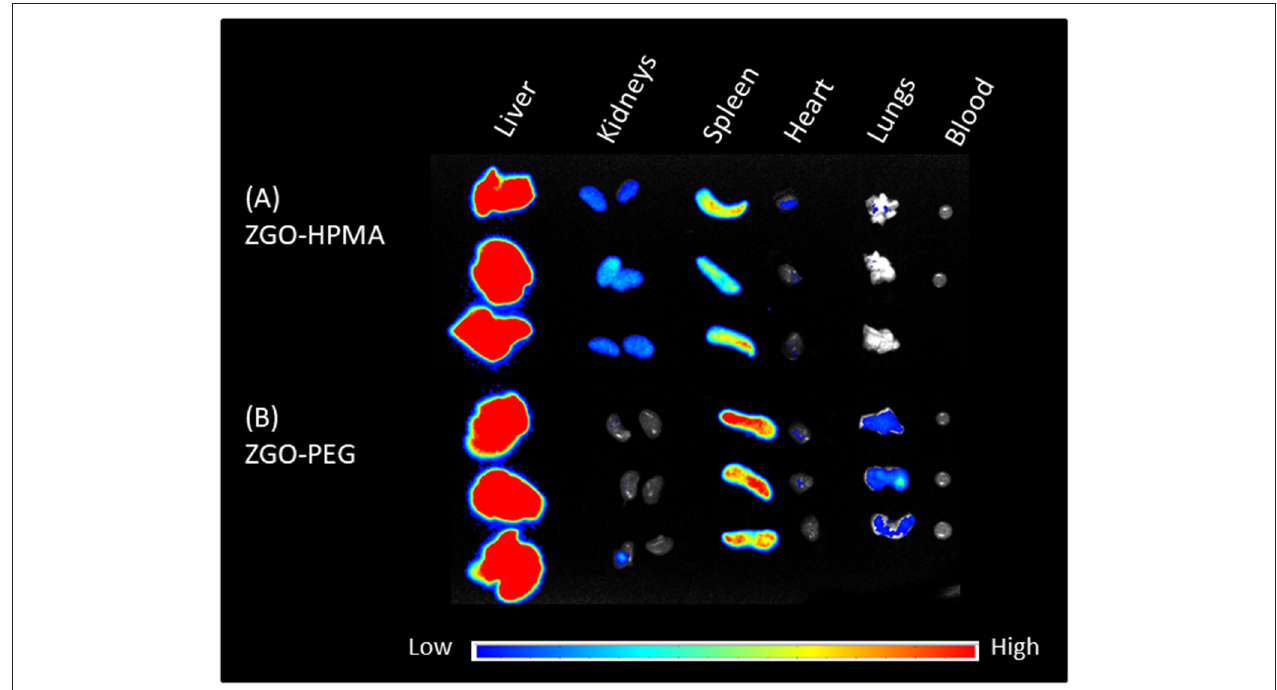
FIGURE 6 | Ex vivo imaging of main organs and blood 24h after injection. (A) ZGO-HPMA. (B) ZGO-PEG.